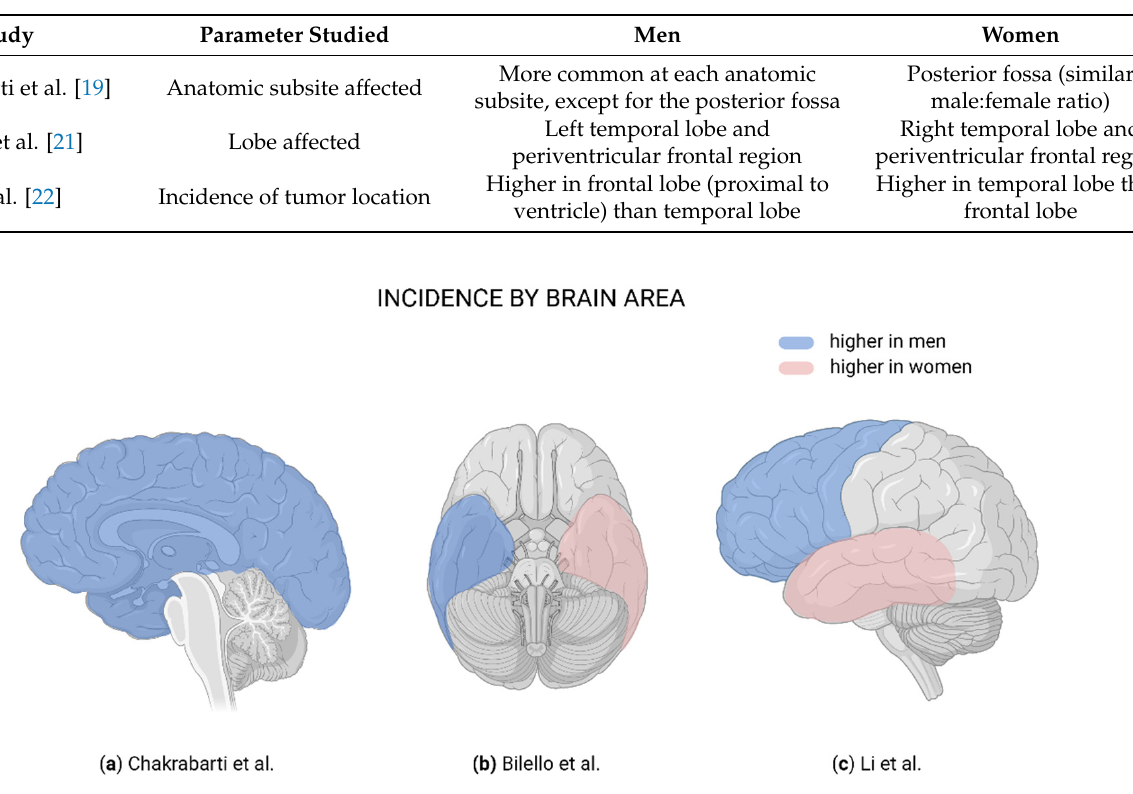
Table 2. Clinical Differences Between Men and Women in Glioblastoma.